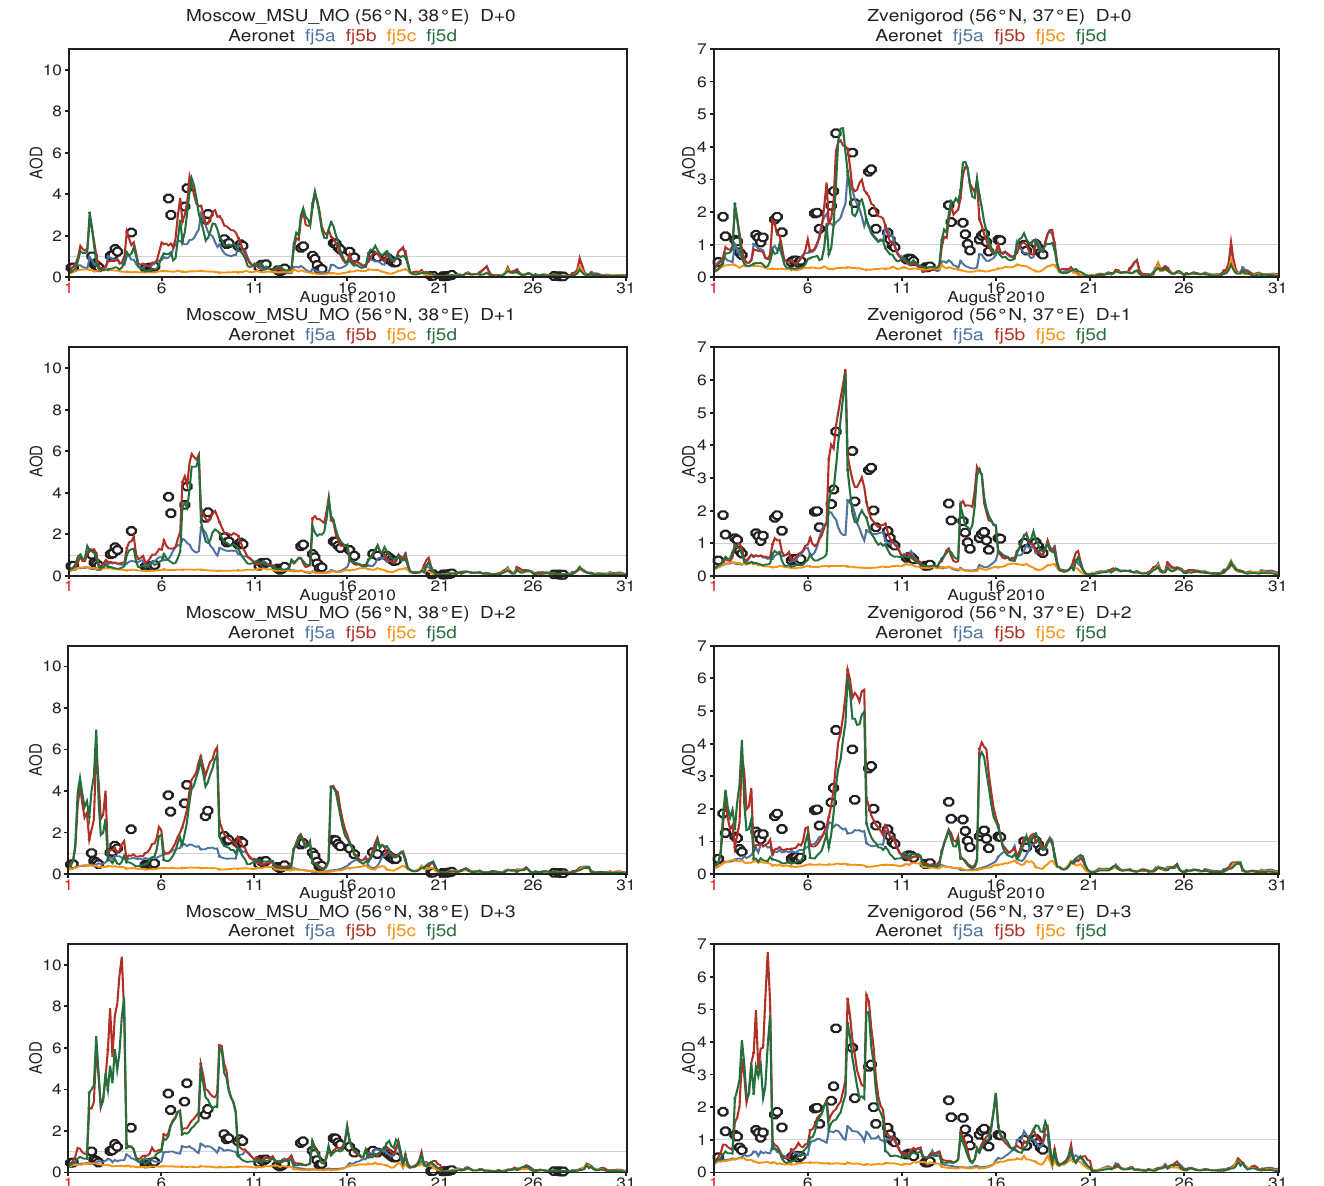
Fig. 12. Simulated AOD at 550µm (lines) compared to AERONET AOD observations at 500µm (black symbols) for five locations affected by the Russian fires in August 2010. Hindcasts with lead times of 3–24h (D+0, top), 27–48h (D+1, 2 nd row), 51–72h (D+2, 3 rd row) and 75–96h (D+3, bottom). Climatological analysis in blue (fj5a), NRT analysis in red (fj5b), climatological model in yellow (fj5c), NRT model in green (fj5d). (Zvenigorod: AERONET data courtesy Mikhail A. Sviridenkov. Others: AERONET level 2 data from http: